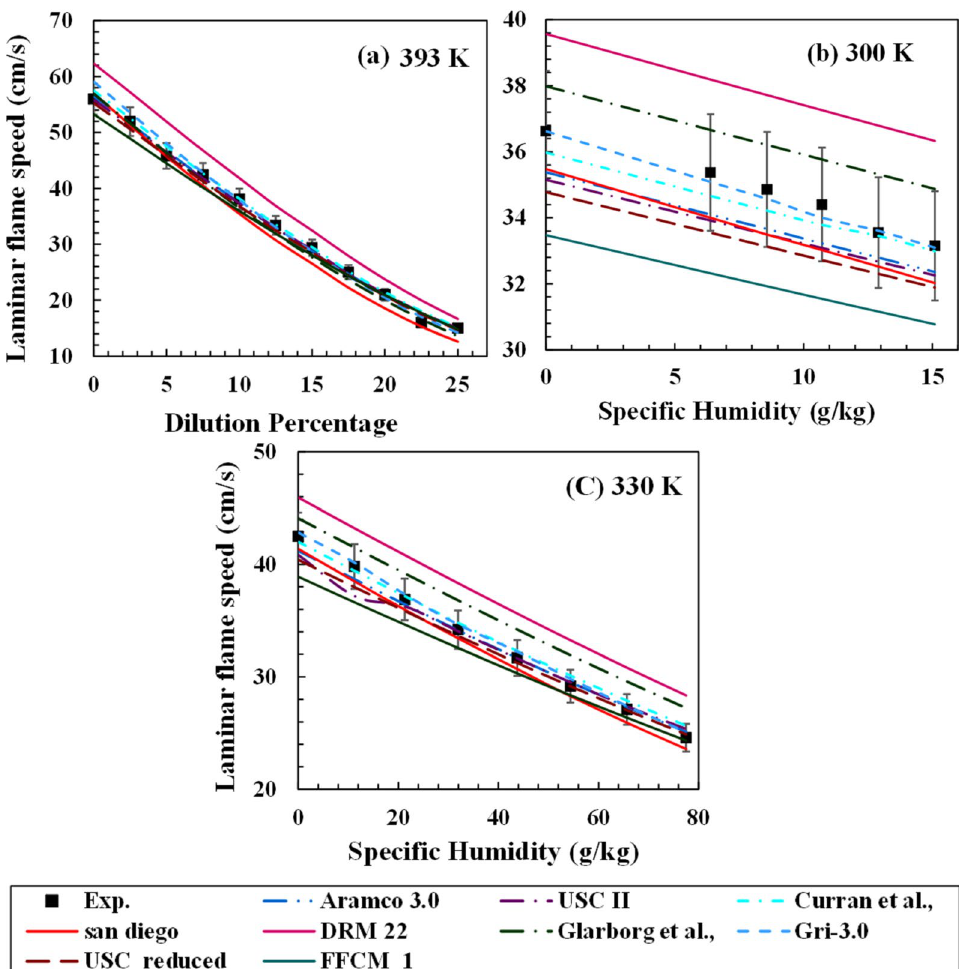
Figure 10. Comparison of different mechanisms with dilution varying ( a ) from 0 to 25% steam in CH 4 /air mixture at 393 K, 34 and ( b , c ) from 0 to 100% relative humidity in CH 4 /air mixture at 300 K and 330 K. 40 .